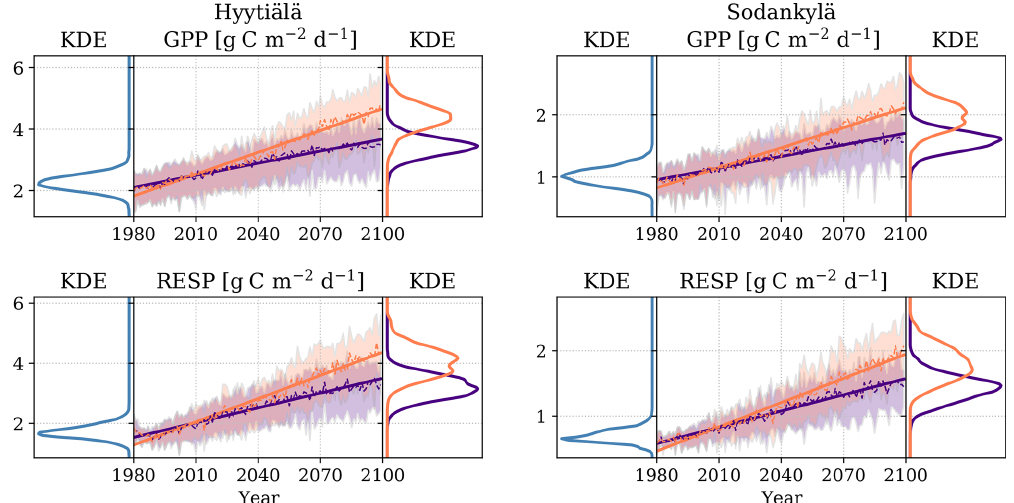
Figure 4. JSBACH predicted annual values of GPP and ecosystem respiration for RCP4.5 (purple) and RCP8.5 (orange) scenarios. The shaded area represents all RCP-specific simulations, the dashed line is the annual mean and the solid line is the trend line. The KDE estimates on the left side of each image represents the distribution of the reference period values of both RCP scenarios (blue), whereas the KDE on the right side consists of RCP-specific values from the last 30 years of simulations.